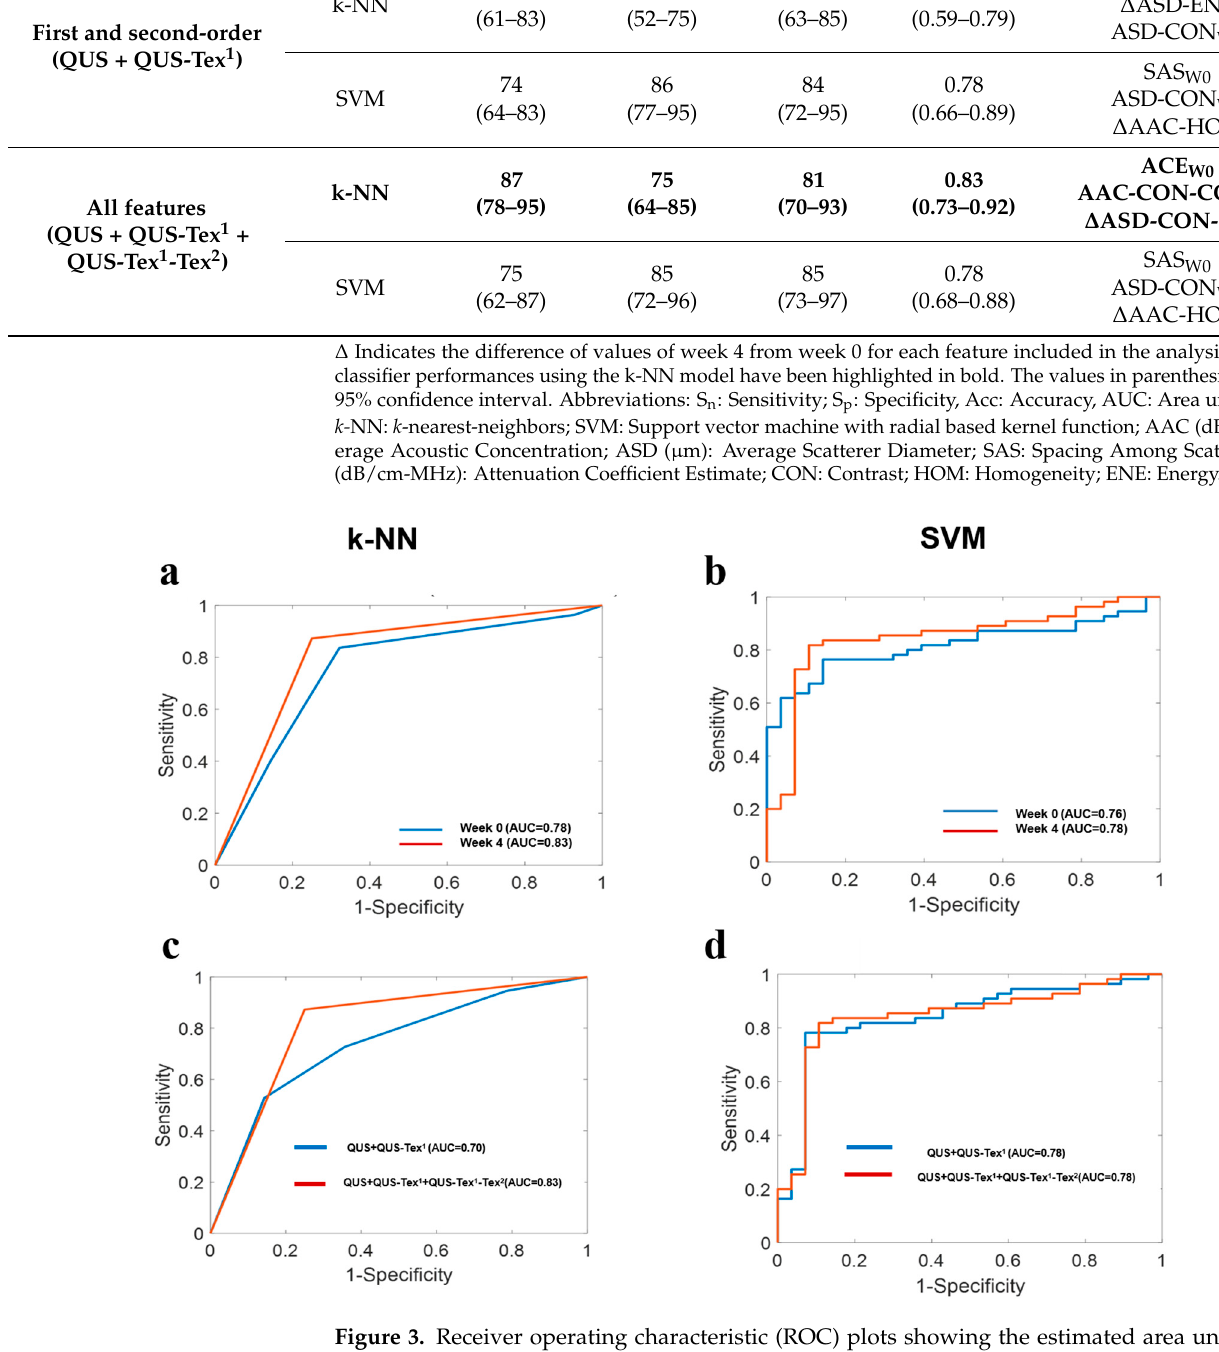
Table 3. Classification performance of the two machine learning classifiers with the selected features.